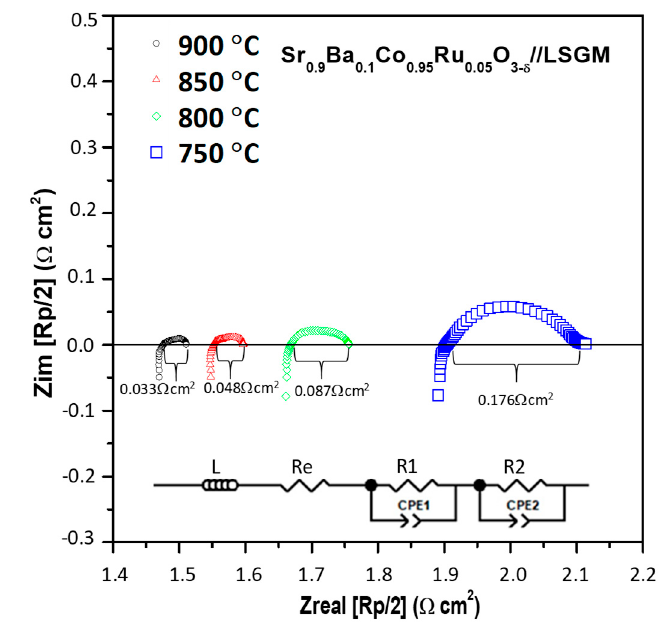
Figure 7. Impedance spectra obtained at different temperatures in symmetrical cells of Sr 0.9 Ba 0.1 Co 0.95 Ru 0.05 O 3 − δ onto LSGM electrolyte. The activation energy ( E a ) for Sr 0.9 Ba 0.1 Co 0.95 Ru 0.05 O 3 − δ can be obtained from the Arrhenius plots